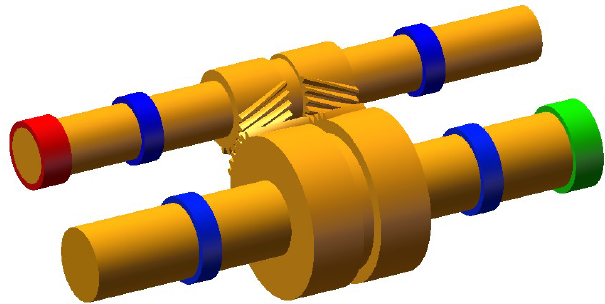
Figure 11. A three-dimensional model of a single-stage herring- bone gear system.